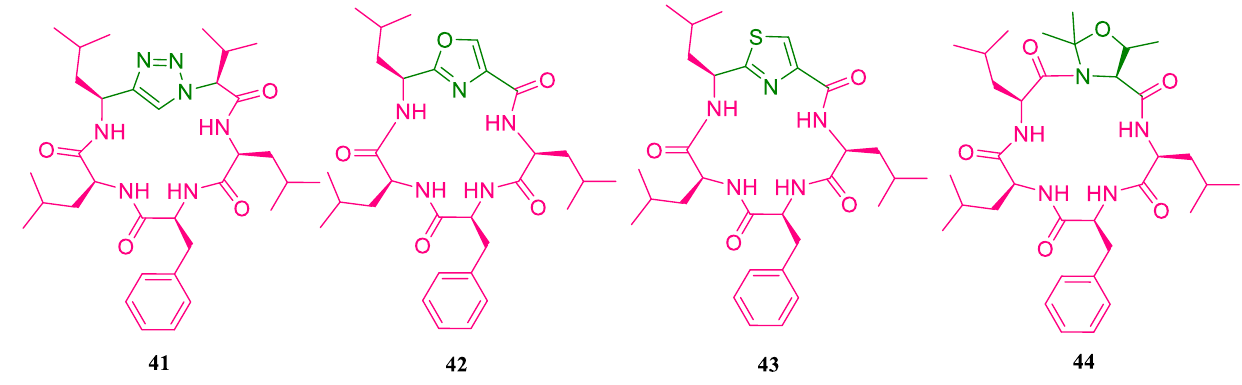
Figure 42. Sansalvamide A peptidomimetics.